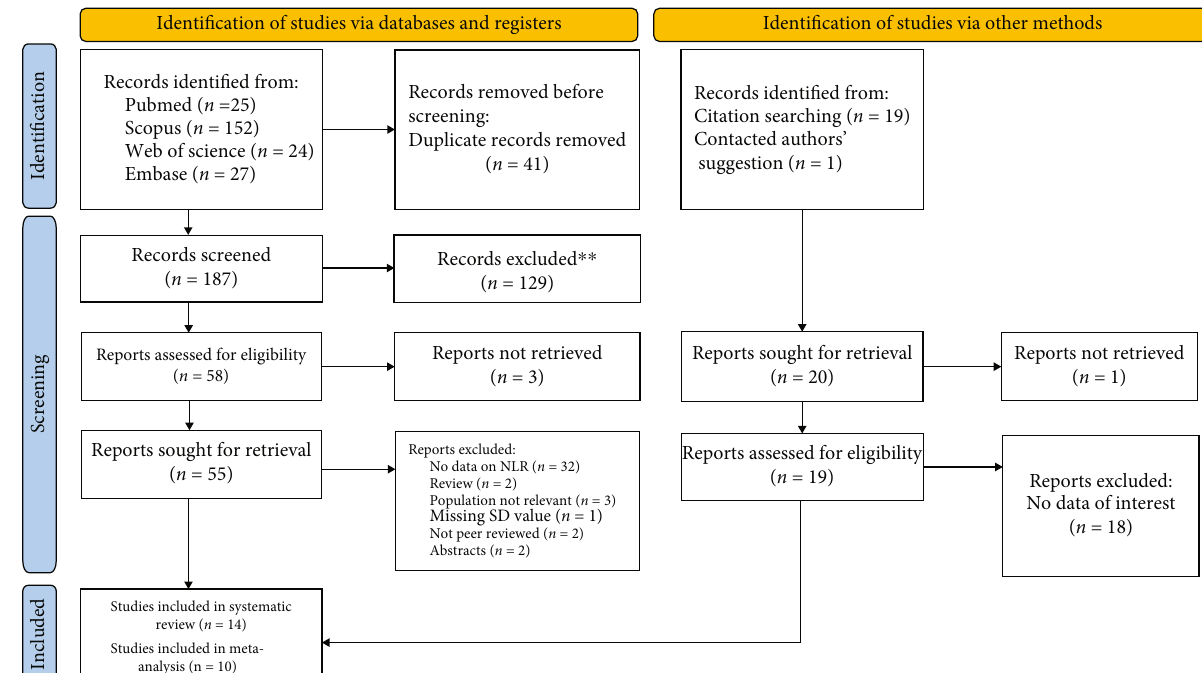
Figure 1: Flowchart of search and study